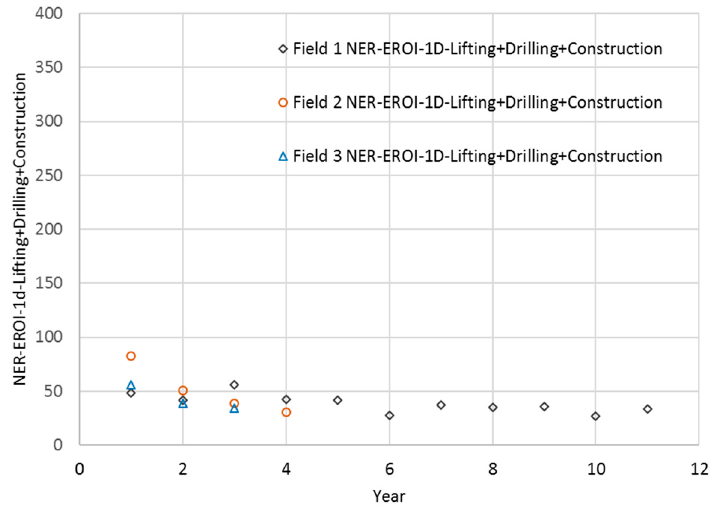
Figure 8. NER-EROI-1d Lifting + Drilling + Construction for three fields.